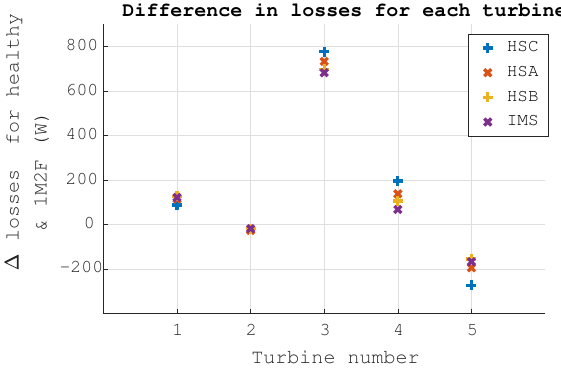
Figure 6. Dataset 1 thermal network model results.